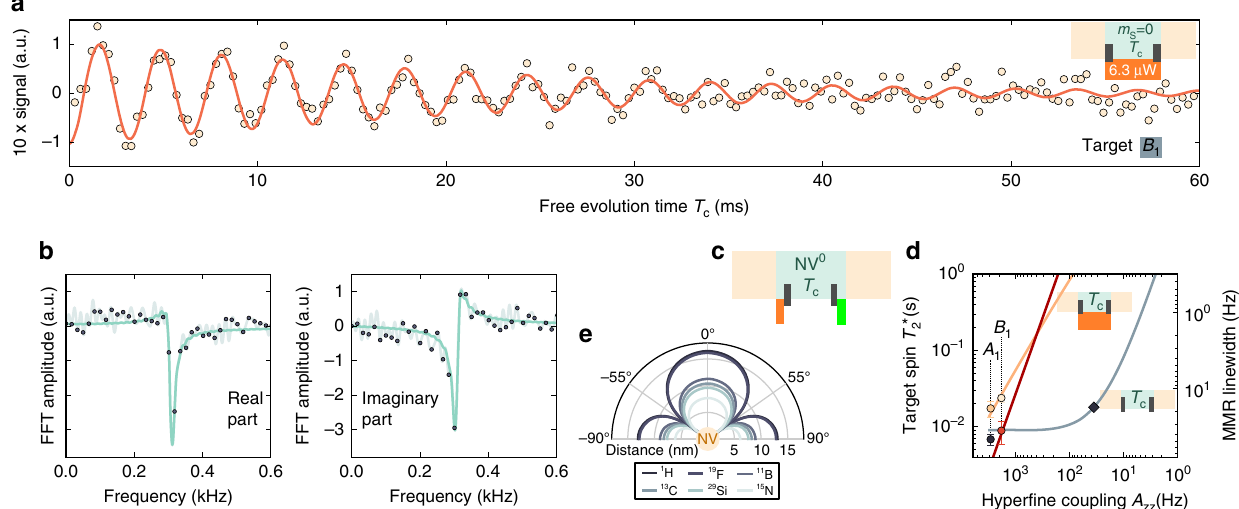
Fig. 4 Scaling of decoupling techniques for improved spectral resolution. a Ramsey oscillations of a different NV with a − 1.8 kHz-coupled 13 C spin (target B ± 2.9 ms. b Fourier transform of ( a ). Analogous to Fig. 3c and d, 1 ) during constant sensor-spin repumping. The decay constant of the oscillation is 23.8 the dark gray points are the transform of the unprocessed measurement data, the light gray line is the transform of the zero- fi lled signal. The green line is the simultaneous fi t of the real and imaginary part of the transformation. The linewidth was determined to be 13.3 ± 1.6 Hz. c Simpli fi ed measurement scheme of the target decoherence, whereas the sensor is in its neutral charge state. Before applying the fi rst π /2 pulse on the target spin, the NV center is pumped to the NV 0 state by applying a 1 ms orange laser pulse with a power of 100 μ W. The charge state is afterwards recovered by applying a short green laser pulse. d Simulated sensor limits on coherence times (lines) of a target nuclear spin coupled to an NV center, when using one of the aforementioned decoupling methods. The gray curve is for the plain NV − , the red for the NV 0 case (see c ). The orange line shows the coherence time limit, when using the optimal optical repolarization rate for every coupling (see “ Methods ” ). All measured coherence times of this work are displayed as color-coded circles. The shown errors correspond to the standard error of the exponential fi t to the decay of the spin state. The gray diamond marks the hypothetical coupling strength at which the plain NV − exerts a dissipative-decoupling effect, which doubles the target spins coherence time limit. In e , the possible location